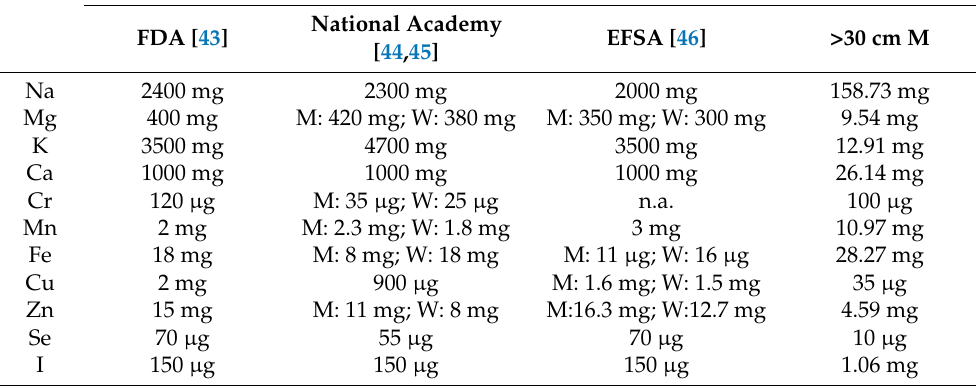
Table 3. Comparison between various sources for the recommended daily intake (RDI) for essential minerals with the minerals detected in F. vesiculosus : FDA: Food and Drug Administration; EFSA: European Food Safety Authority; M: Male; W: Women; n.a.: not available. Mineral Recommended Daily Intake (RDI) vs. F. vesiculosus Mineral Composition National Academy FDA [43] 2400 mg